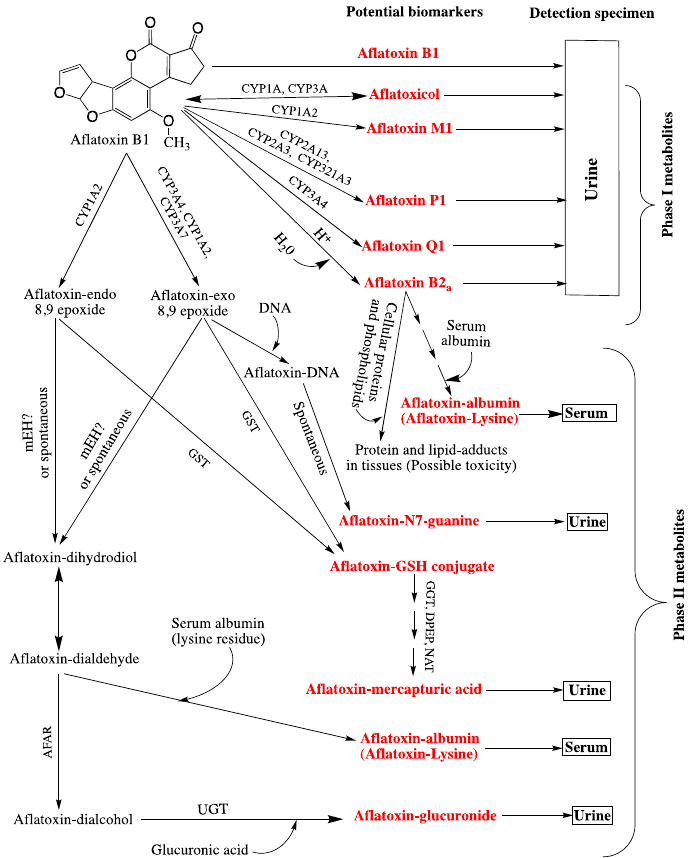
Figure 1. Fate of aflatoxin B1 in the liver showing the metabolites with potential to be used as biomarkers “in red boldface letters” for exposure determination and the biofluids where they can be detected and quantified. For the details on the formation of aflatoxin-albumin adduct from aflatoxin B2a, see Figure 2 below. Adapted from [146]. Abbreviations : CYP: Cytochrome P450 enzymes; GGT: γ -glutamyltranspeptidase;